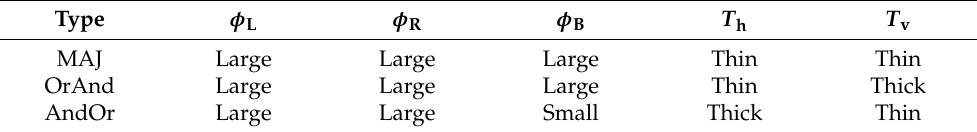
Table 2. Key parameter configuration of three-input TFETs with different logic behaviors.